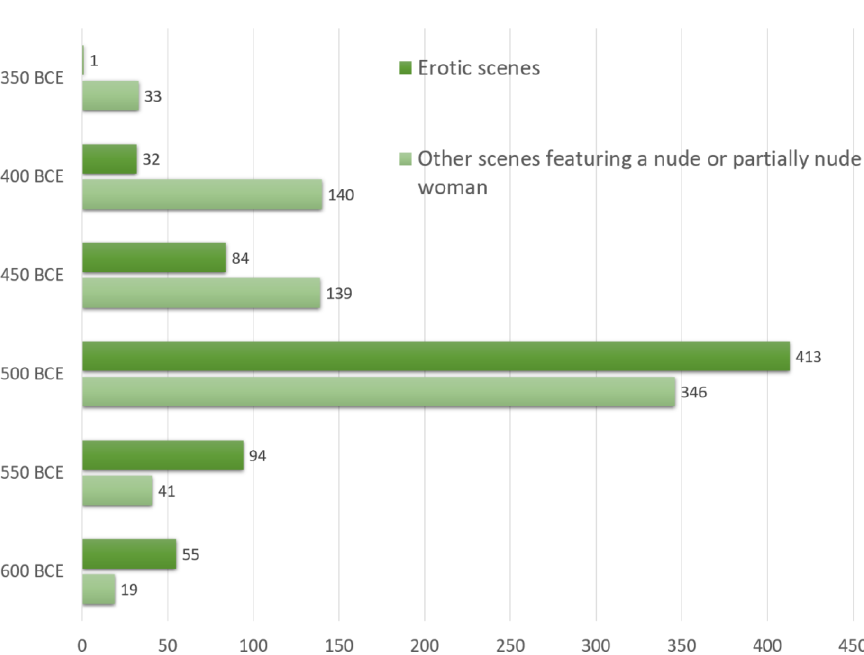
Figure 16. Relative numbers of representations of explicitly erotic scenes including female nudity and other scene types that include a fully or partially nude woman, including all known provenances. Data from the BAPD. Chart created by author.